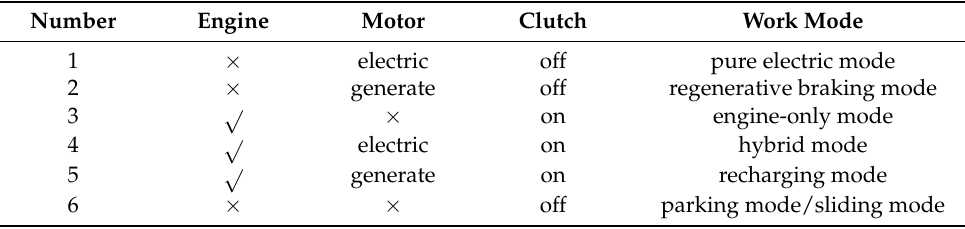
Table 2. The main work modes of PHEV with P2 configuration.